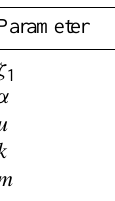
Table 2. Parameters estimated for application of GEV